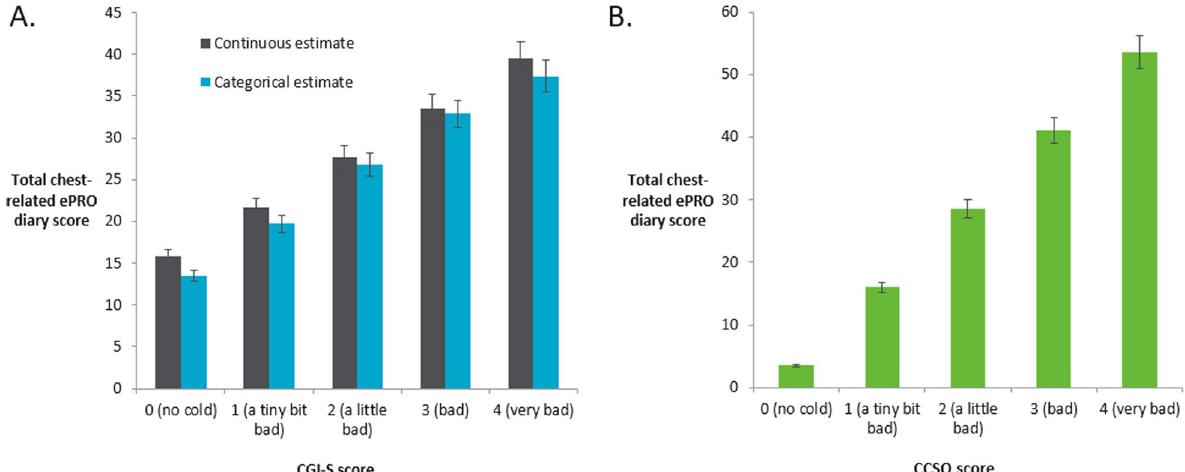
Fig. 6 Known groups validity of the chest-related ePRO as defined based on CGI-S ( A ) and CCSQ ( B )